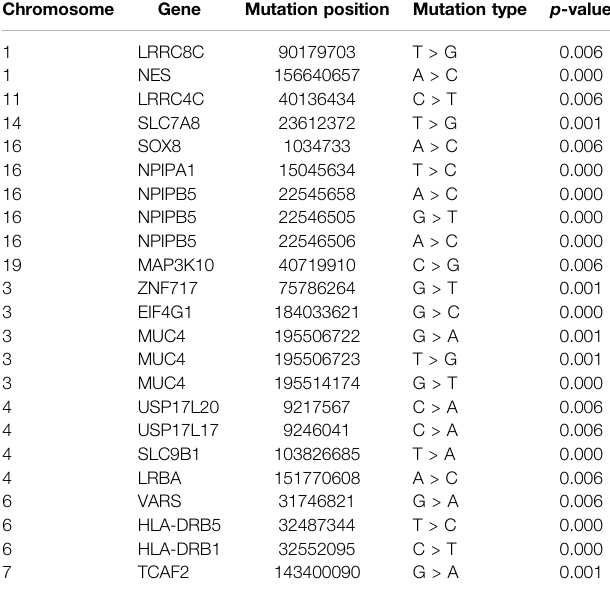
TABLE 2 | SNP fi ltering Based on Fisher Exact Test.